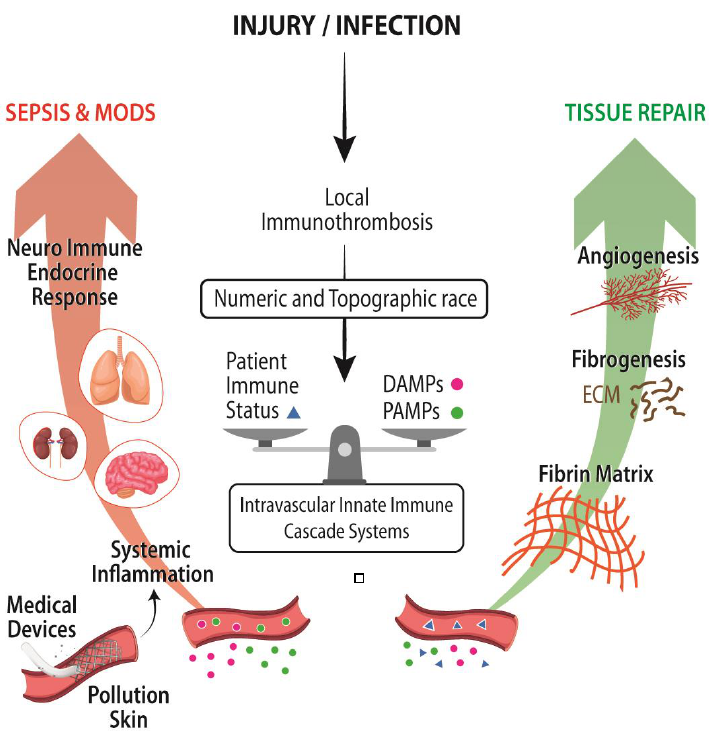
Figure 3. Immunothrombosis as a mosaic of defense mechanisms, including the activation of nocicep- tors, endothelial cells, fibroblasts, tissue-resident macrophages, circulating platelets and neutrophils, and plasma innate immune cascade systems, leads to curtailing and compartmentalizing the damage, thereby giving way to tissue repair. However, when the triggering emergency cannot be handled in a tissue autonomous manner (due to the patient status, a severe polytrauma, and/or the use of cutting-edge medical strategies), the numeric and topographic race between DAMPs and PAMPs, and the well-developed local checks tips the balance towards a gradual or massive entry of biotic and abiotic molecules into the bloodstream. In this new infectious or sterile inflammatory context, the blood-born cascade and the neuroendocrine systems may be systemically dysregulated, thereby causing a systemic inflammatory response syndrome (SIR). Moreover, the activation of the auto- nomic nervous system results in a barrier dysfunction that may lead to multiple organ dysfunction syndrome (MODS) and sepsis